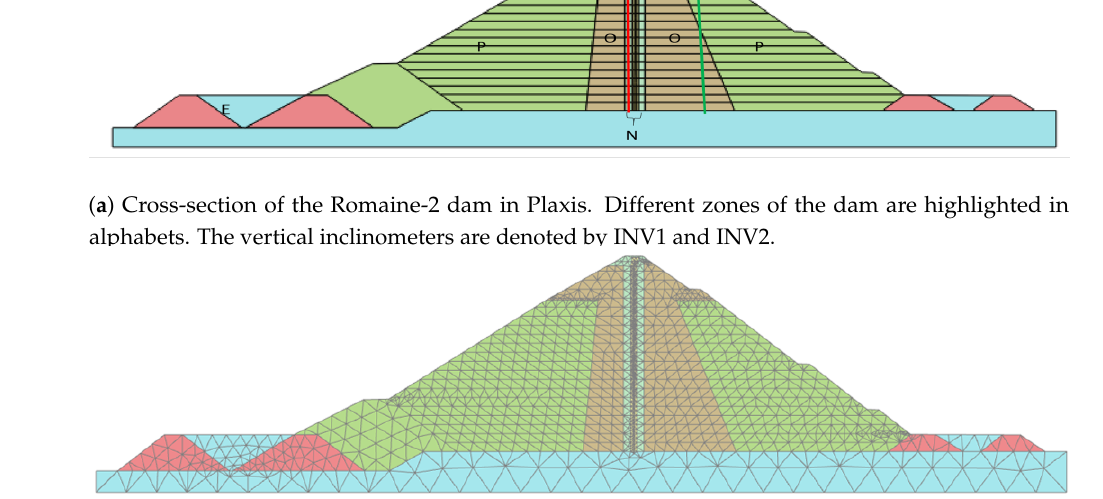
Figure 3. Romaine-2